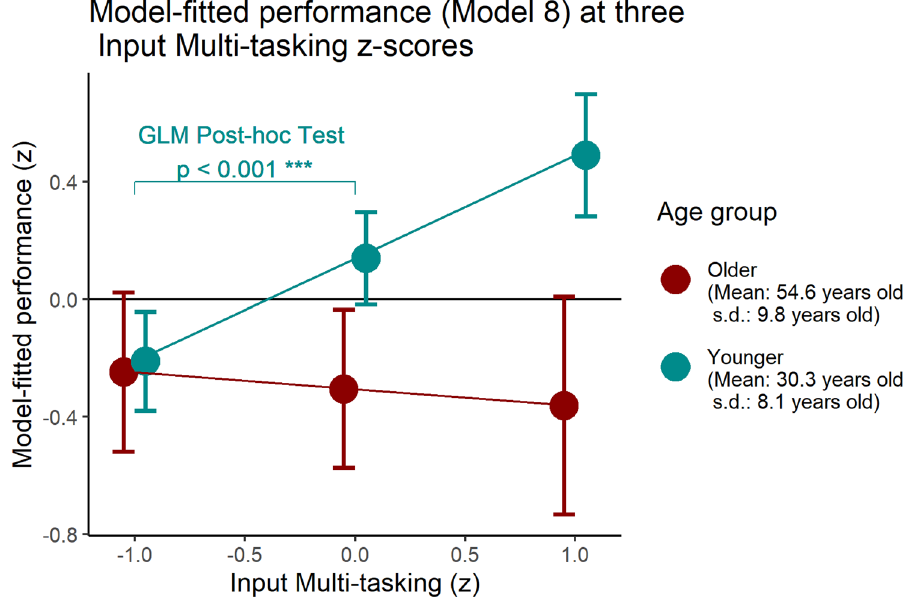
Figure 5. Performance as a function of Input Multi-tasking, separated by grouping (as previously